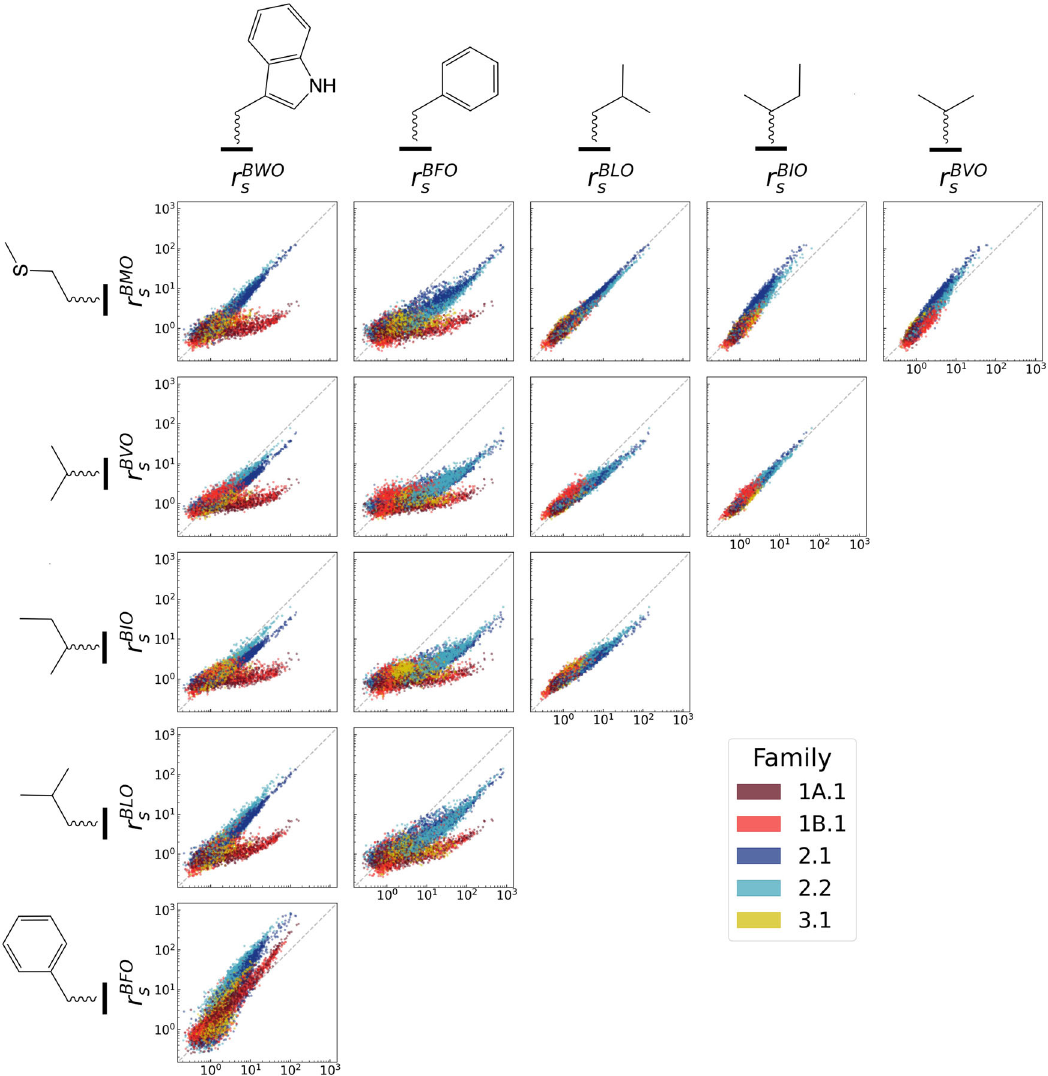
Fig. 2 Pairwise comparisons of activity on different substrates. Pairwise comparisons of catalytic enhancement ( r s ) for individual sequences with each BXO substrate. Dashed gray line indicates the identity line. Substrates are ordered by hydrophilicity 89 . See Supplementary Fig. 6 for error bars and mutant order for each family. Source data are provided as a Source Data fi